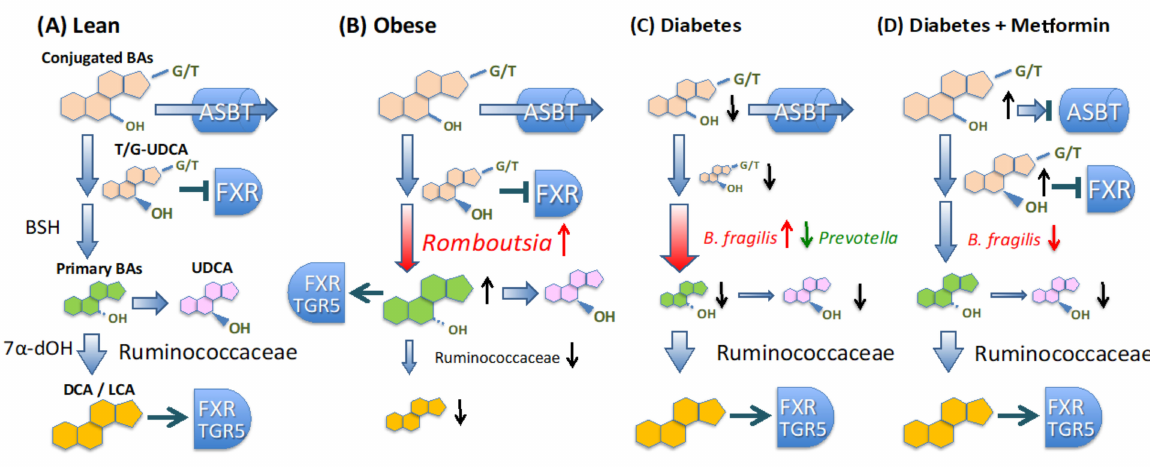
Figure 7. Hypothesized model of the key taxa-related BA metabolism in Indonesian gut linking to obesity and T2D. ( A ) In healthy lean subjects, conjugated BAs, secreted into the upper intestine are reabsorbed into the liver via apical sodium bile salt transporter (ASBT). Unabsorbed BAs are deconjugated by bacterial bile salt hydroxylase (BSH). Non-digested conjugated BAs, particularly TUDCA and GUDCA, contribute to glucose homeostasis through the antagonistic inhibition of FXR signaling. In the lower intestine, the deconjugated BAs are further metabolized by bacterial 7 α -dehydroxylase (7 α -dOH) or 7 β -hydroxysteroid dehydrogenase to form 7 α -dehydroxylated BAs, namely DCA, LCA, and UDCA, respectively. The highly diversified commensal taxon, Ruminococcaceae, is mainly involved in the 7 α -dehydroxylation. The primary and secondary BAs act agonistic with different affinity to TGR5 and FXR, which coordinate metabolic homeostasis. ( B ) In the obese subjects, fecal primary BA level was increased with the increase in Romboutsia and decrease in Ruminococcaceae. ( C ) In the T2D subjects, TUDCA and GUDCA was decreased with the increase in B. fragilis equipped with strong BSH activity. The lack of antagonistic activity of TUDCA and GUDCA to FXR impairs glucose homeostasis. UDCA showing anti-diabetic aspect was also decreased with increase in Ruminococcaceae. ( D ) Metformin elevates the concentration of total BAs by inhibiting ASBT and inhibits the growth of B. fragilis , which eventually improve glucose